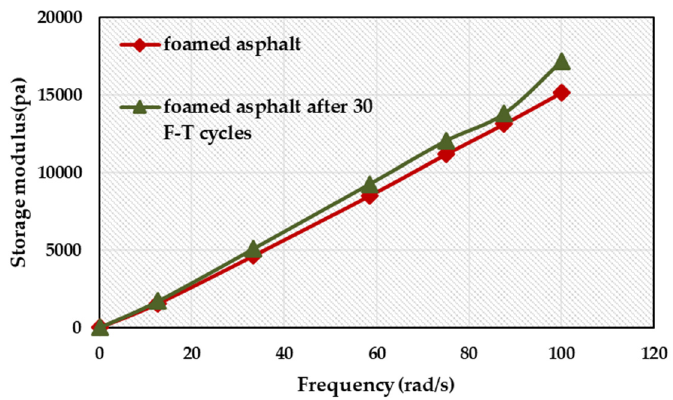
Figure 12. Storage modulus of foamed asphalt and foamed asphalt with 30 F–T cycles.